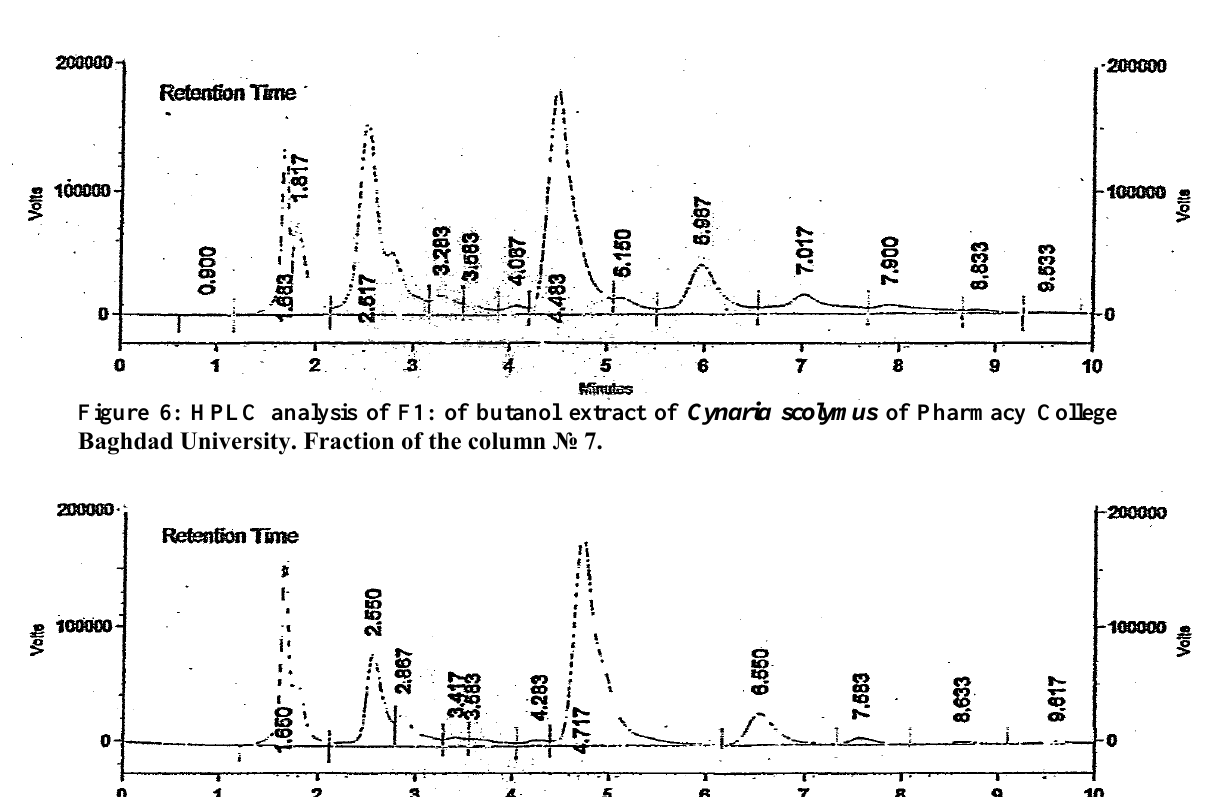
Figure 5: HPLC analysis of F2 of butanol extract of Cynaria scolymus of Pharmacy College Baghdad University. Fraction of the column № 6.